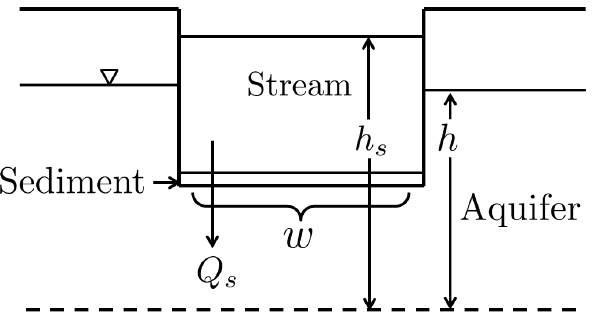
Figure 1. Cross-sectional view of the stream as it is interpreted by the STR package of MODFLOW. The hydraulic head of the stream ( h to a datum that is represented as a dashed line. The flow across the streambed ( Q as the width of the streambed ( w ) are also